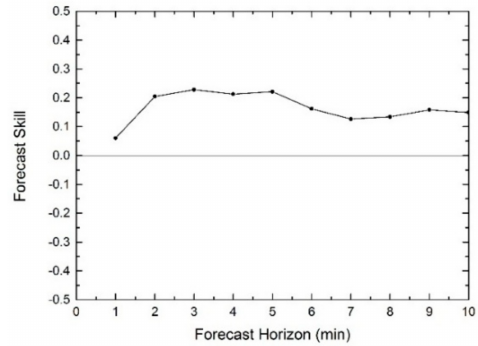
Figure 6. The forecast skill over the persistence of the proposed forecast method for the three